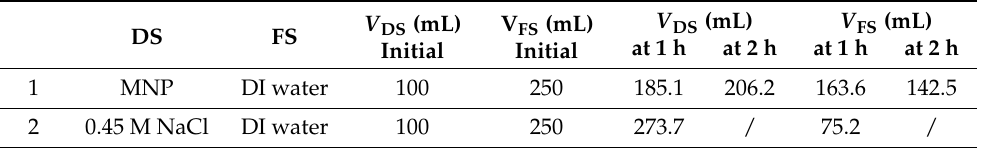
Table 5. The initial and final volumes of the DS and FS.